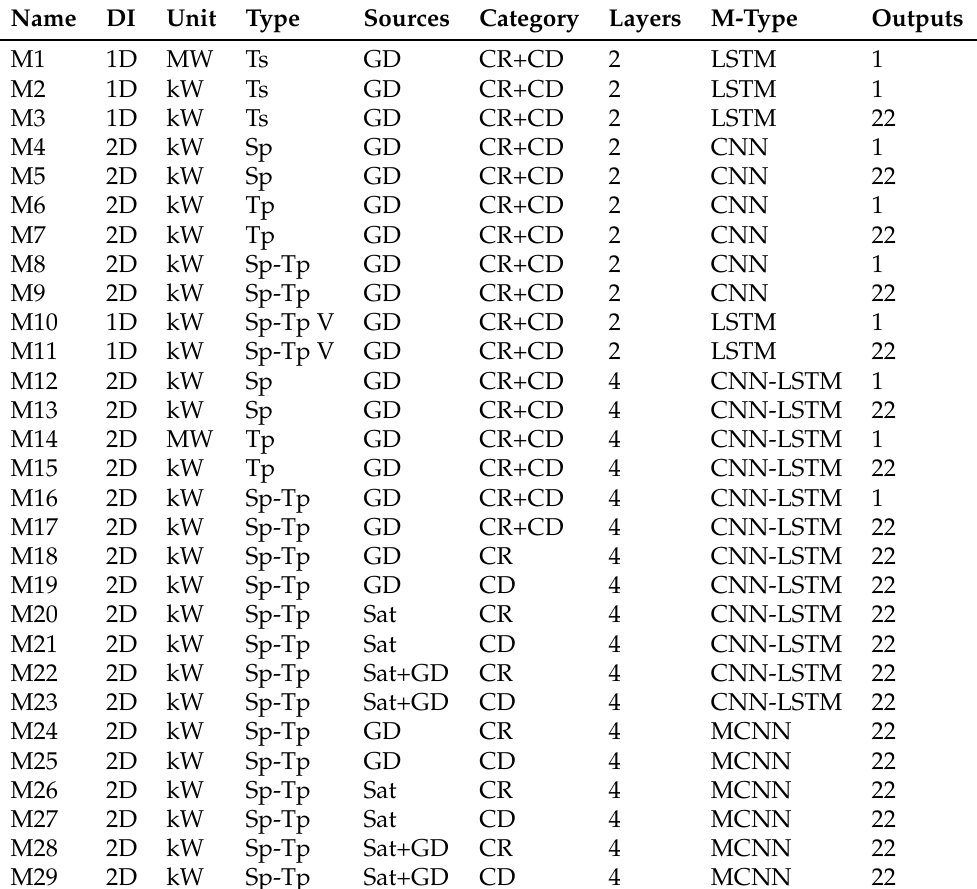
Table 2. Experiment settings and